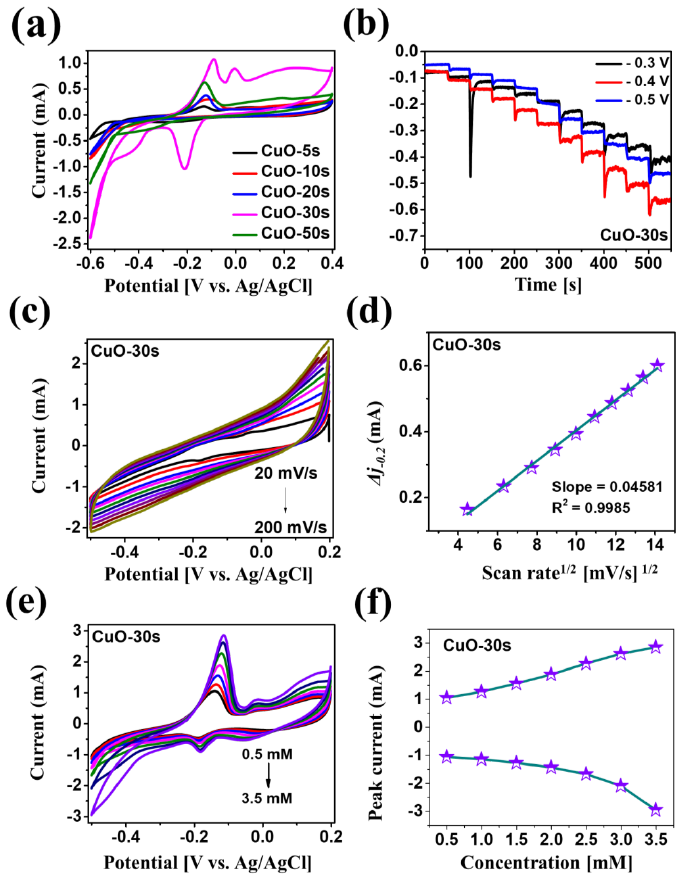
Figure 3. ( a ) Cyclic voltammetry (CV) response of various porous CuO/Pt hybrid detectors in 0.1 M PBS (pH 7.4) containing 0.4 mM H 2 O 2 at a scan rate of 50 mV/s. ( b ) Amperometric response of CuO-30 s sample with the dropwise addition of 0.1 mM H 2 O 2 at different applied potential. ( c ) CVs response of the CuO-30 s sample at different scan rates from 20 to 200 mV/s in 0.1 M PBS (pH 7.4) containing 0.1 mM H 2 O 2 . ( d ) Capacitive current Vs square root of scan rate calibration plots for the CuO-30 s at –0.2 V ( Δj −0.2 = ( j a − j c )/2). ( e ) CV of CuO-30 s sample in 0.1 M PBS (pH 7.4) containing di ff erent concentrations of H 2 O 2 ranging from 0.5 to 3.5 mM at the scan rate of 50 mV / s. ( f ) Relation between peak current with respect to H 2 O 2 concentration at − 0.5